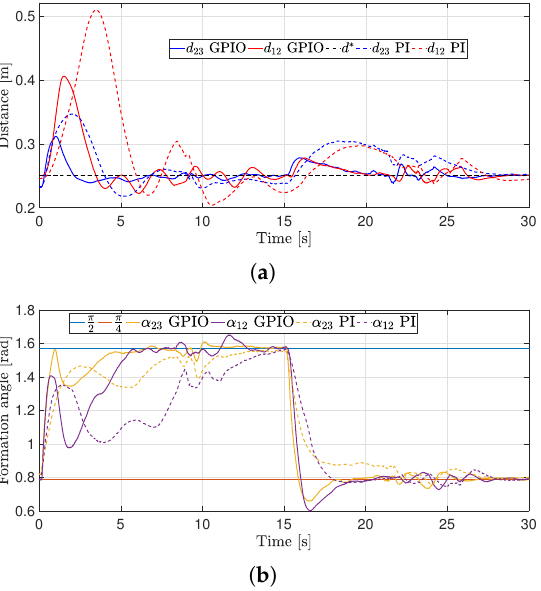
Figure 13. Distances and formation angles between the robots for the second experiment. ( a ) Distances between the robots. ( b ) Formation angles between the